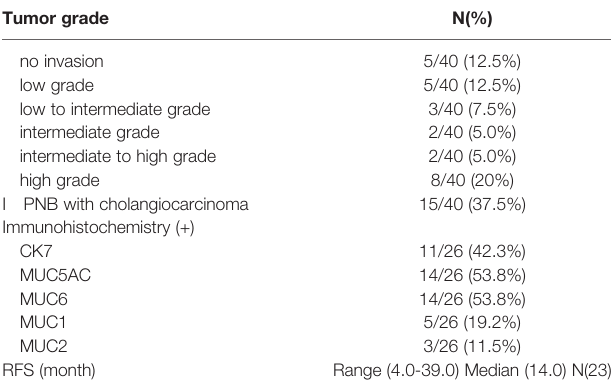
TABLE 3 | The pathological features and RFS of